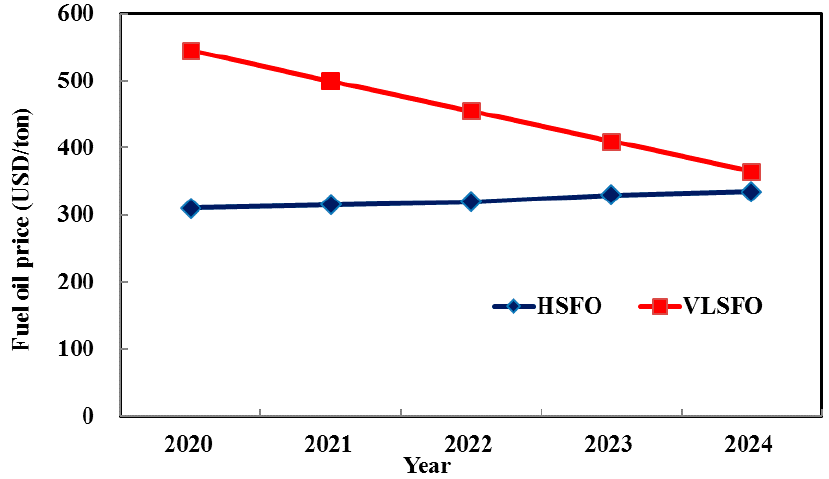
Figure 2. Variation of estimated price of fuel oils in the next 5 years. Source: plotted by authors based on data of [32].